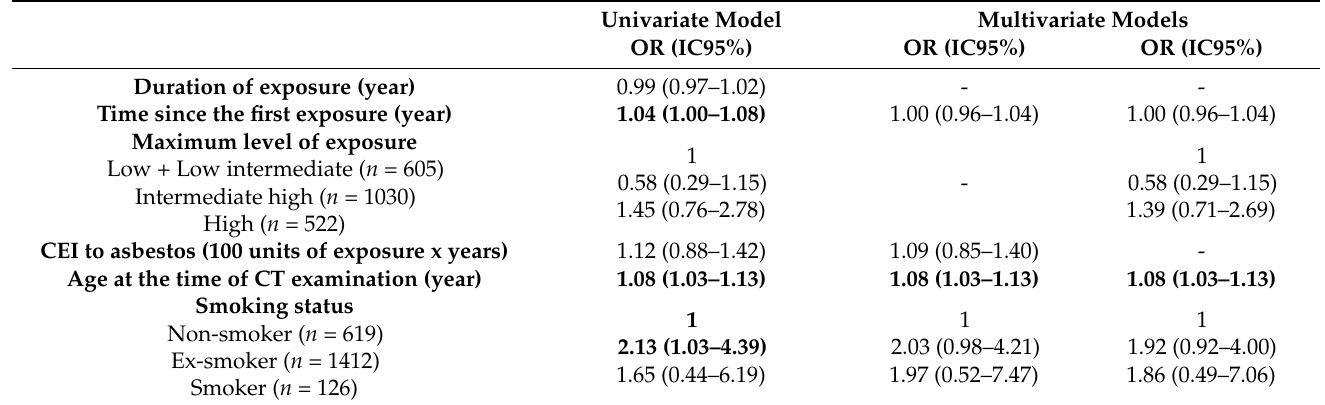
Table 3. Association between the possible or definite UIP pattern at CT, asbestos exposure and age unadjusted and adjusted on age, occupational asbestos exposure and smoking status.